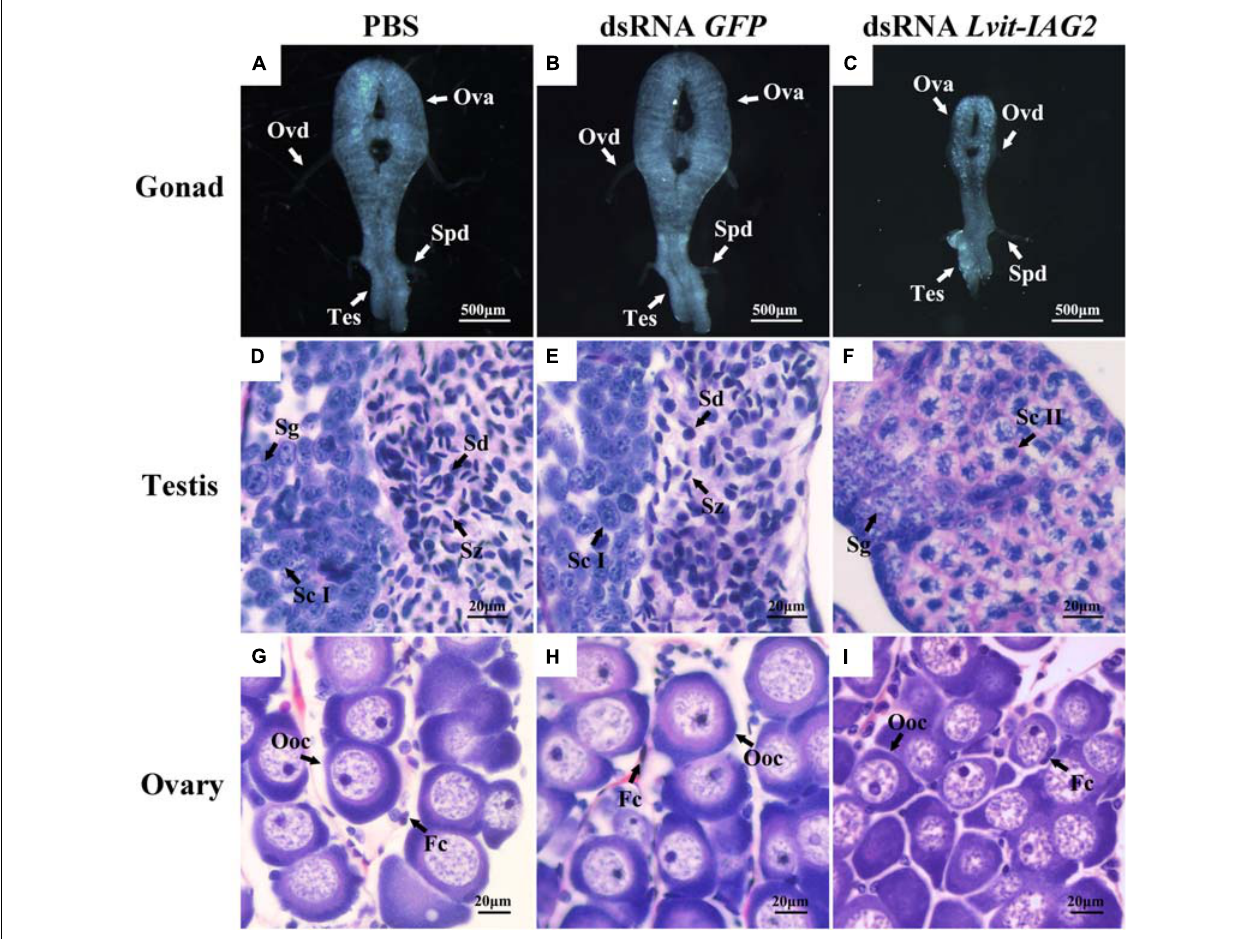
FIGURE 8 | Effects of Lvit-IAG2 silencing on gonadal development of L. vittata. Gonad morphology and characteristics were photographed at the end of the 30 day experiment following in vivo injection of PBS (A) , dsRNA GFP (B) , or dsRNA Lvit-IAG2 (C) . Hematoxylin and eosin (H & E)-stained sections was used for structure description. Testicular region mainly consisted of Sg and Sd/Sz in PBS (D) and dsRNA GFP (E) injection treatments while the majority of cells in the testicular region of dsRNA Lvit-IAG2 injected treatment were Sc II (F) . Ovarian regions of the shrimp from the Lvit-IAG2 silencing treatment were more transparent and smaller in relative size (C) . Compared with the PBS-injected (G) and dsRNA GFP -injected (H) group, oocytes were less developed and arranged more tightly and disorderly in the dsRNA Lvit-IAG2 -injected group (I) . Ova, ovary; Tes, testis; Ovd, oviduct; Spd, sperm duct; Oog, oogonia; Ooc, oocytes; Fc, follicular cell; Sg, spermatogonia; Sc I, primary spermatocyte; Sc II, secondary spermatocyte; Sd, spermatid; Sz,